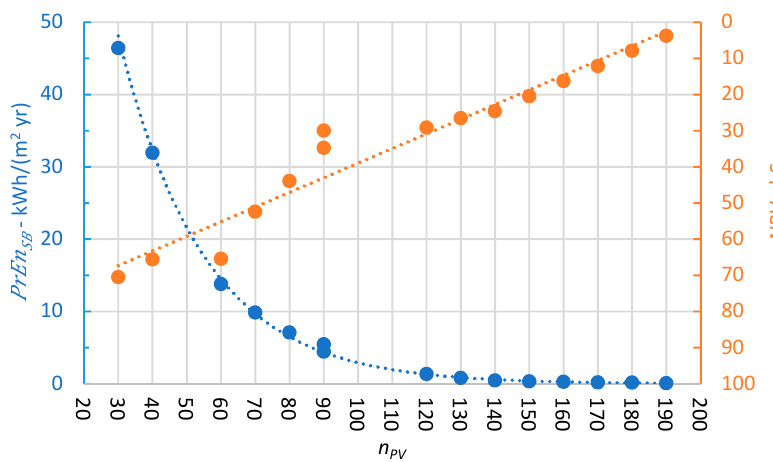
Figure 6. Energy consumption and net present value as a function of the number of PV modules on the Pareto frontier.